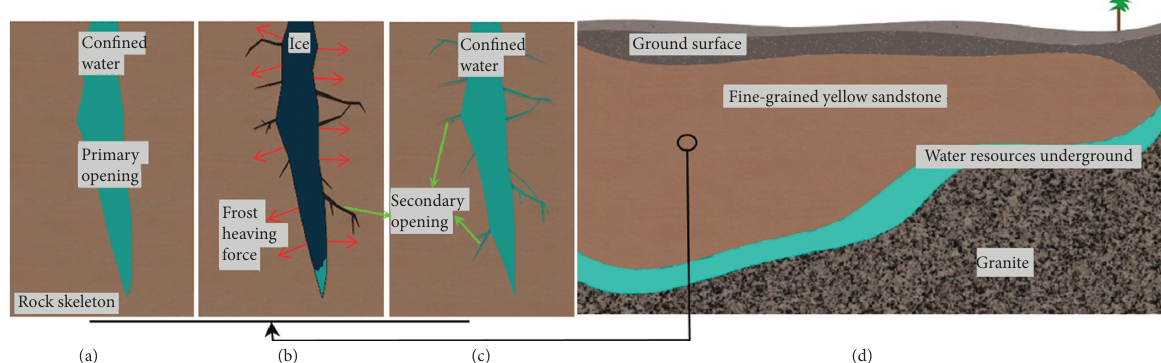
Figure 12: Schematic diagram of freeze-thaw cycle.